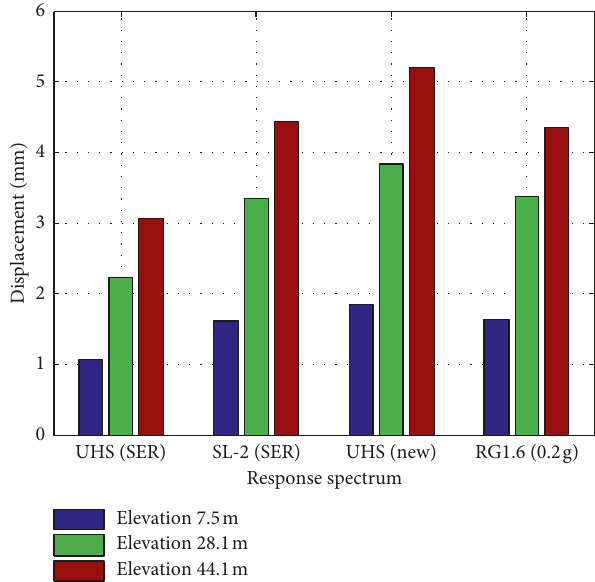
Figure 14: Displacement peaks in different